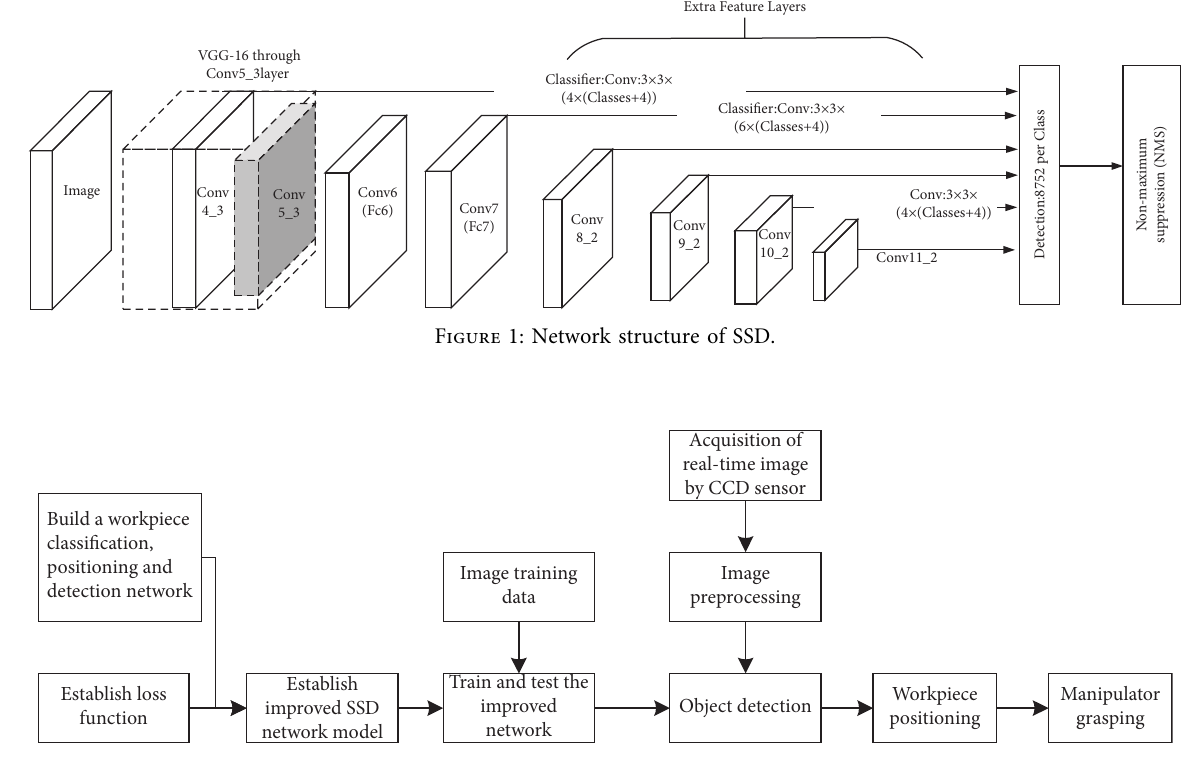
Figure 2: Workpiece inspection process based on improved SSD network.